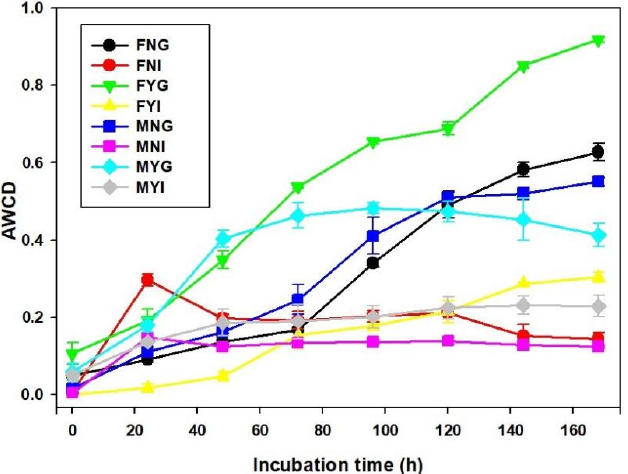
Figure 8. Average well color development (AWCD) variation in EcoPlates.